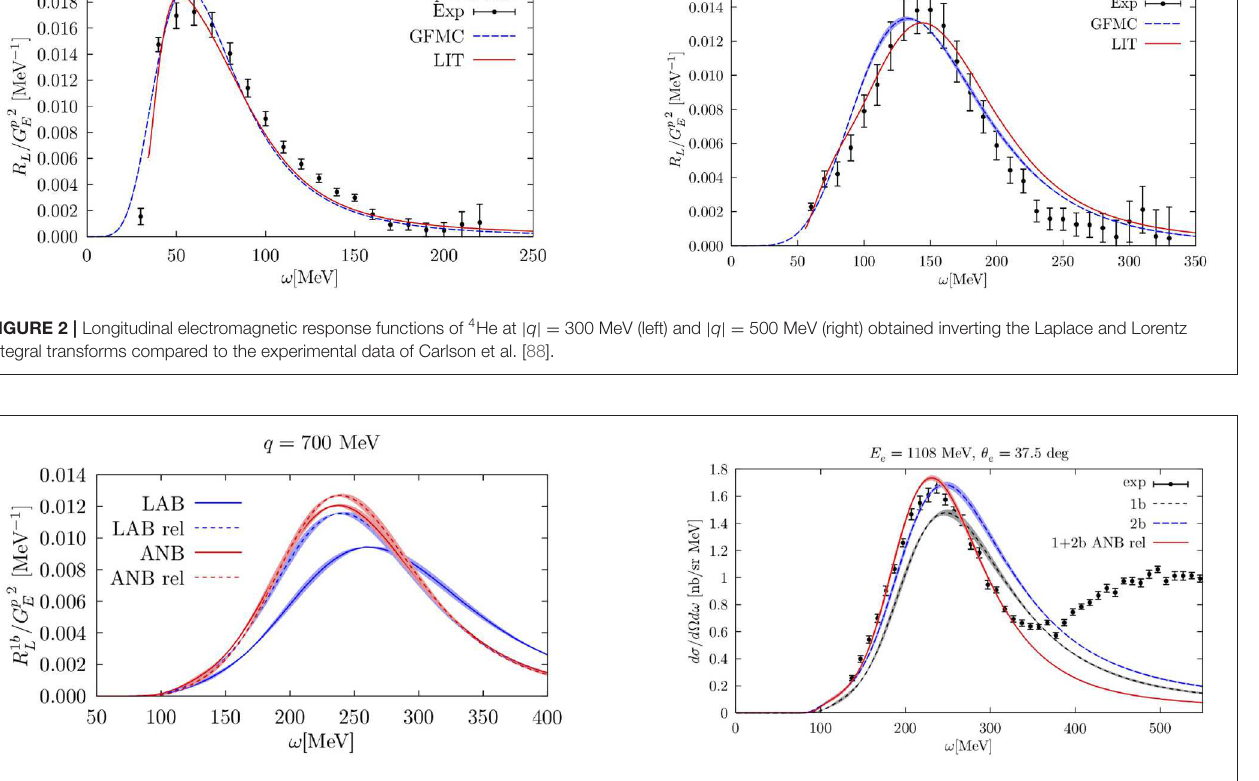
FIGURE 3 | (Left) Longitudinal electromagnetic response functions of 4 He at | q | = 700 MeV computed in the LAB and in the ANB frame are displayed by the blue and red solid curves, respectively. The dashed curves have been obtained by applying the two-fragment model to consider two-body relativistic kinematics for the final state energy. (Right) Double-differential electron- 4 He cross sections for E e = 1108 MeV and θ = 37.5. The short-dashed red and dashed blue curves are the GFMC calculation were only one- body and one- plus two-body contributions in the electromagnetic currents are accounted for. The results obtained in the ANB frame corrected by the two-fragment model are displayed by the red solid line. The experimental data are taken from Benhar et al. [